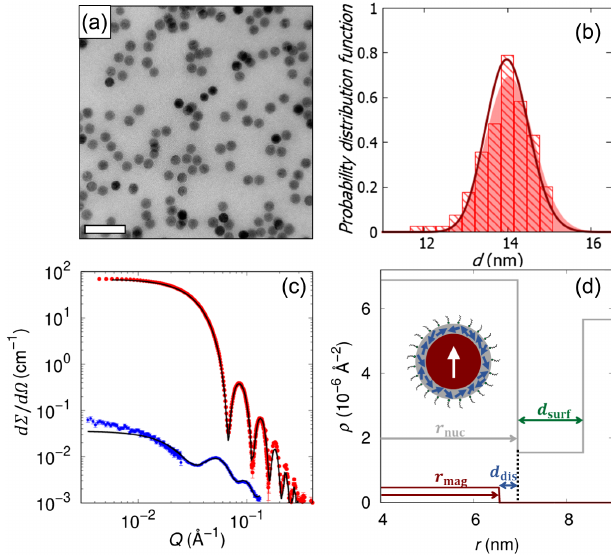
FIG. 2. (a) TEM bright field micrograph (scale bar, 50 nm) and (b) particle-size histogram based on the evaluation of 200 particles along with log-normal particle-size distribution obtained from TEM analysis (red surface) and SAXS refinement (line). (c) SAXS (red dots) and nuclear SANS (blue dots) data along with form factor fit (black lines) and (d) radial profiles of the nuclear ( ρ , gray) and magnetic scattering length densities ( ρ , n mag red). Our model of the magnetic nanoparticle morphology consists of a coherently magnetized particle core with radius r and a magnetically disordered surface shell with thickness mag d within the inorganic NP with radius r , stabilized by the dis nuc oleic acid ligand shell with thickness d surf